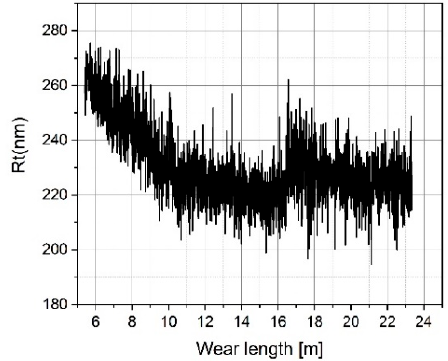
Figure 28. Measured Rt values on the tip-testing standard versus measurement length.